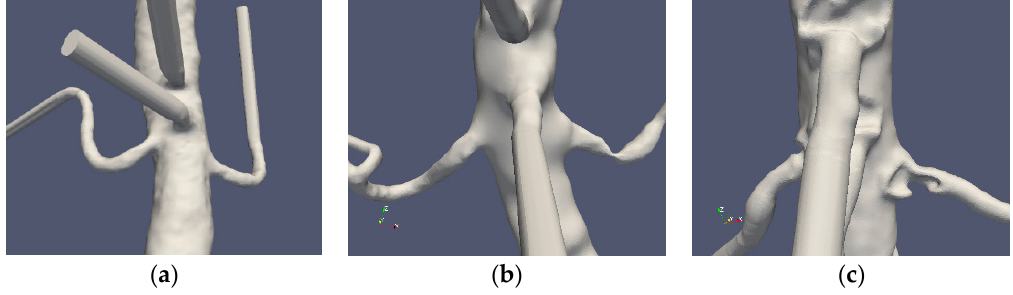
Figure 1. The “normal” renal arteries, (Case0) ( a ), the distal stenosis (Case1) ( b ) and the proximal stenosis (Case2) ( c ).